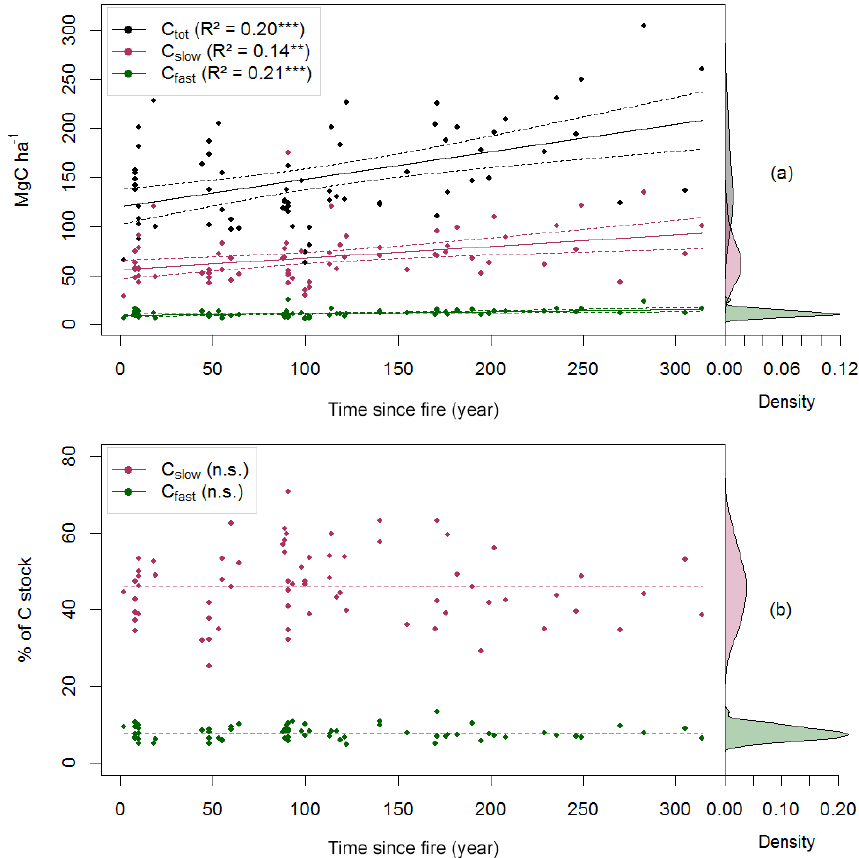
Figure 3. Carbon quality as a function of the time since fire (TSF). The upper panel shows the total soil C reservoir (C tot ), the recalcitrant C pool (C slow ) and the bioreactive C pool (C fast ) sizes as a function of TSF ( a , on the left), and the kernel density for each pool ( a , on the right). The lower panel shows the proportion of C slow and C fast relative to C tot as a function of TSF ( b , on the left) and their kernel density ( b , on the right). ∗∗∗ p < 0 . 001; ∗∗ p < 0 . 01; n.s. p > 0 .